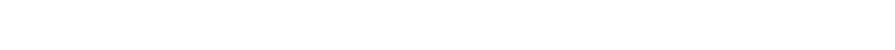
Frontiers in Oncology | Radiation